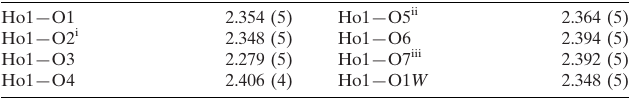
Selected bond lengths (A ˚ ).